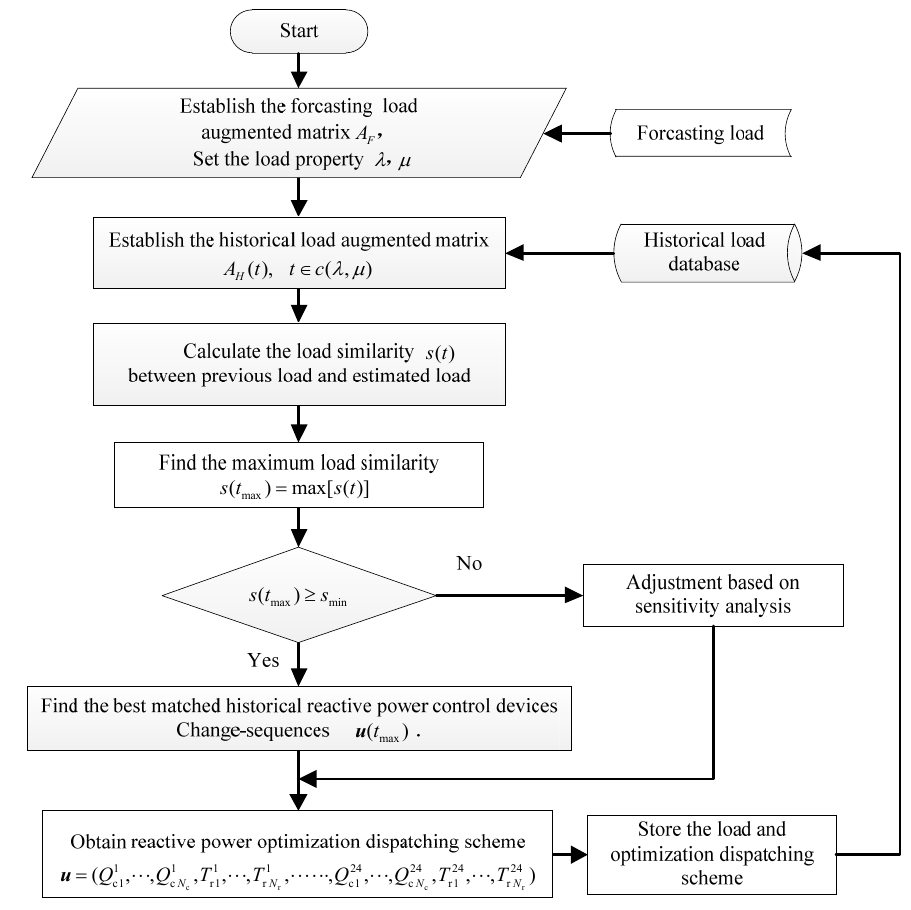
Figure 4. Fine adjustment method based on sensitivity analysis.